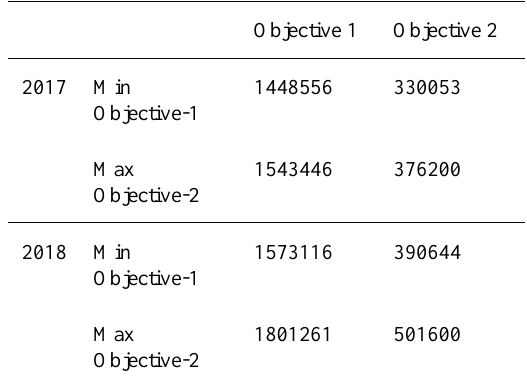
Table 3. Payoff table of 2017 and 2018 for weight based target.